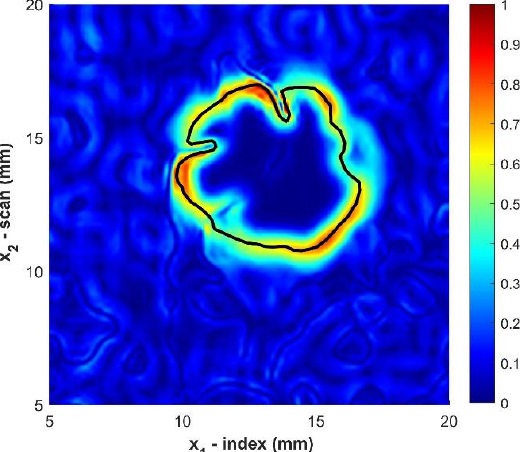
Figure 10. Magnitude of the gradient manually traced for Sample B2. Color indicates normalized amplitude.